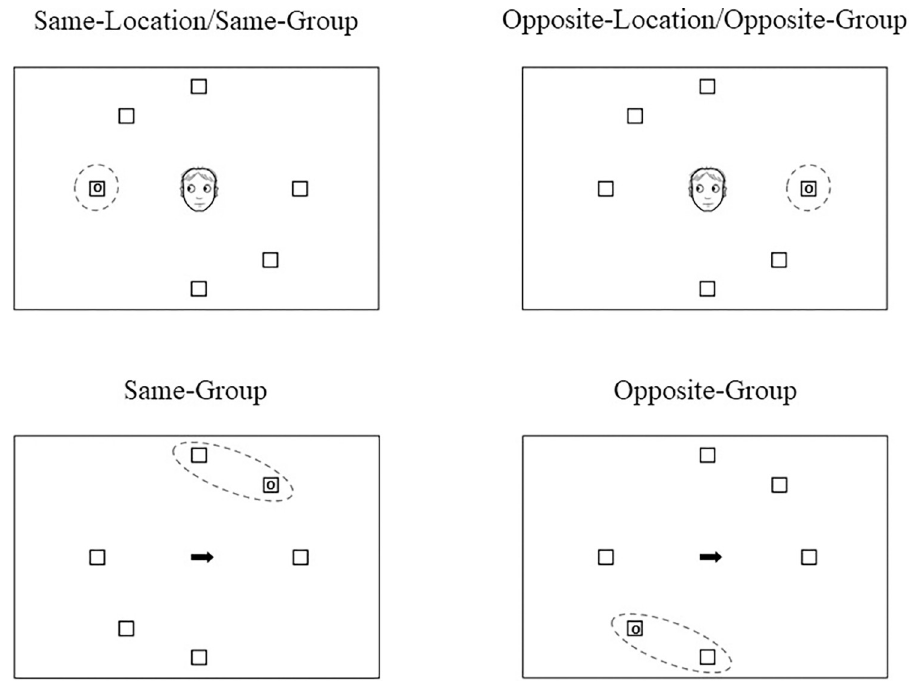
Fig 5. Illustration of the four types of cue-target relation of Experiments 2. The placeholder-group tilted orientation shown here is -45˚ from vertical. The top images represent an example of gaze cue in a placeholder-present condition; the bottom images represent the arrow cue in a placeholder-present condition. The cue-target relation for the placeholder-absent condition was the same, with the exception that no placeholder boxes were presented on the